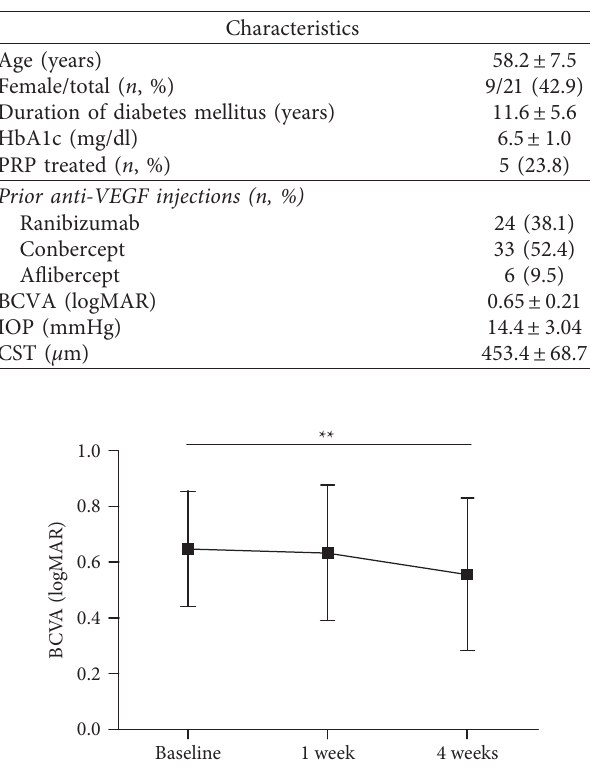
Figure 2: Changes in the BCVA before and after switching to PSTA treatment in eyes with refractory DME. ∗∗ P < 0 . 01 vs. the baseline value.